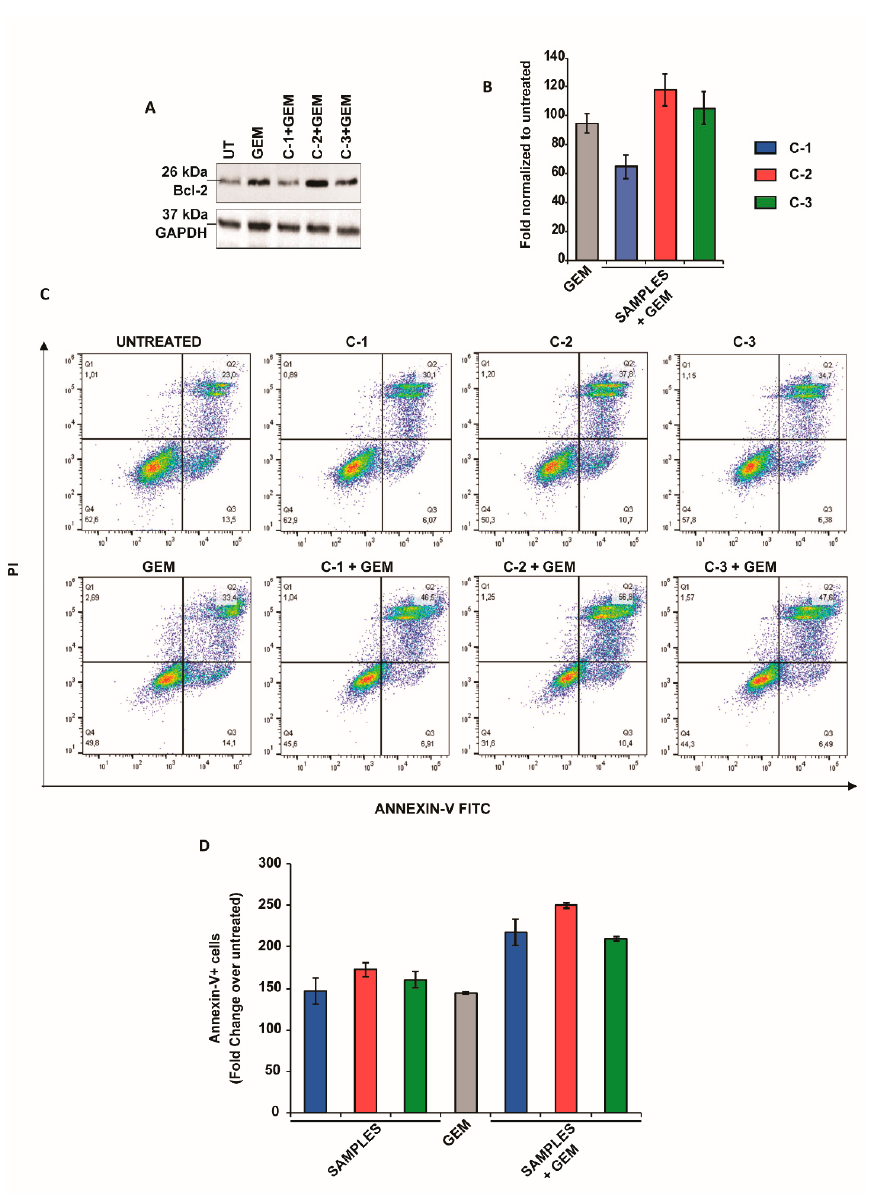
Figure 3. Apoptotic studies in pancreatic cancer cell lines. ( A ) Western blot analysis of Bcl-2 in PANC-1 cells after treatment with 1 mM C-1, C-2, C-3 , and 4.5 µ M GEM for 48 h. GAPDH protein level in the same extract was used as a control loading. ( B ) Densitometry of bands was performed using NIH Image J software and reported as fold change with respect to the untreated condition. The values reported are the mean of three independent experiments and were reported as mean ± SEM. ( C ) Cells were stained with Annexin V and propidium iodide (PI) and analyzed by flow cytometry. The percentage of cells in each group within the gated areas is indicated; the upper right panel represents cells undergoing late apoptosis, and the lower right panel represents cells undergoing early apoptosis. ( D ) Fold change in apoptosis. The values reported are the mean of two independent experiments and were reported as mean ±SEM.